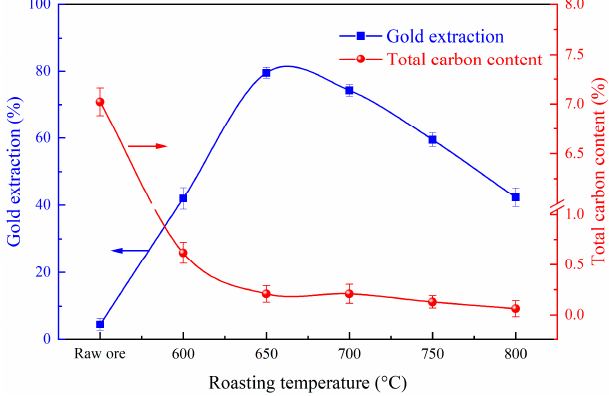
Figure 6. The effect of roasting temperature on gold extraction.